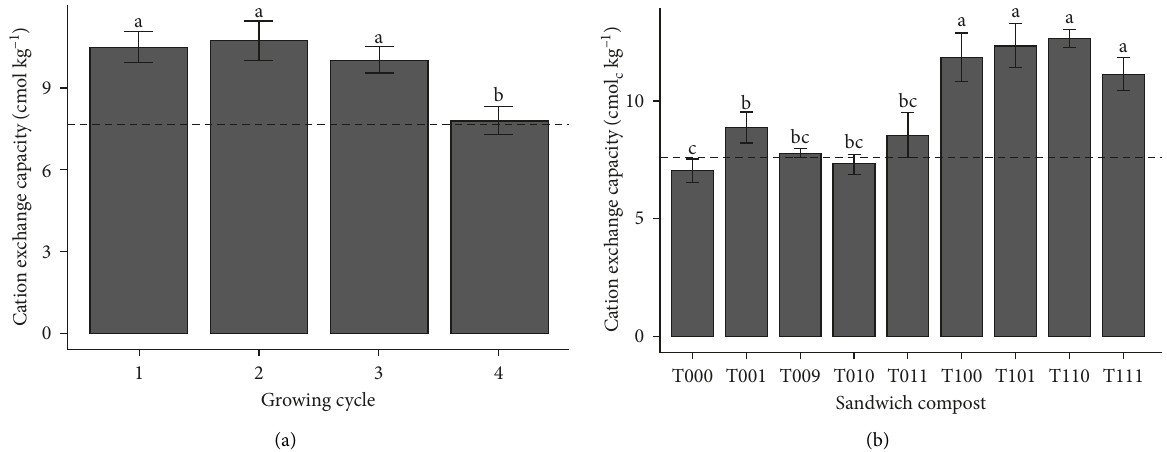
Figure 2: . (a) Effect of the growing cycle on cation exchangeable capacity (cmol exchangeable capacity (cmol c kg − 1 ). Mean ± standard error with different letters is significantly different at P < 0 . 05 when using DMRT. The dotted line is referred to as the original cation exchange capacity (7.6 cmol c kg − 1 ).